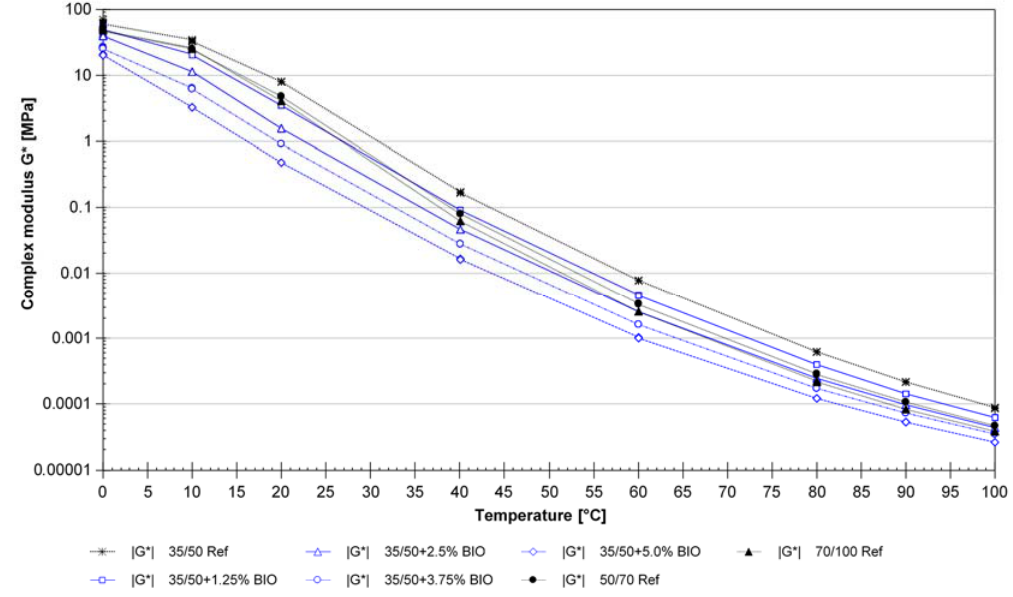
Figure 2. Complex modulus |G*| for reference bitumens and 35/50 bitumen modified with bio ‐ agent.